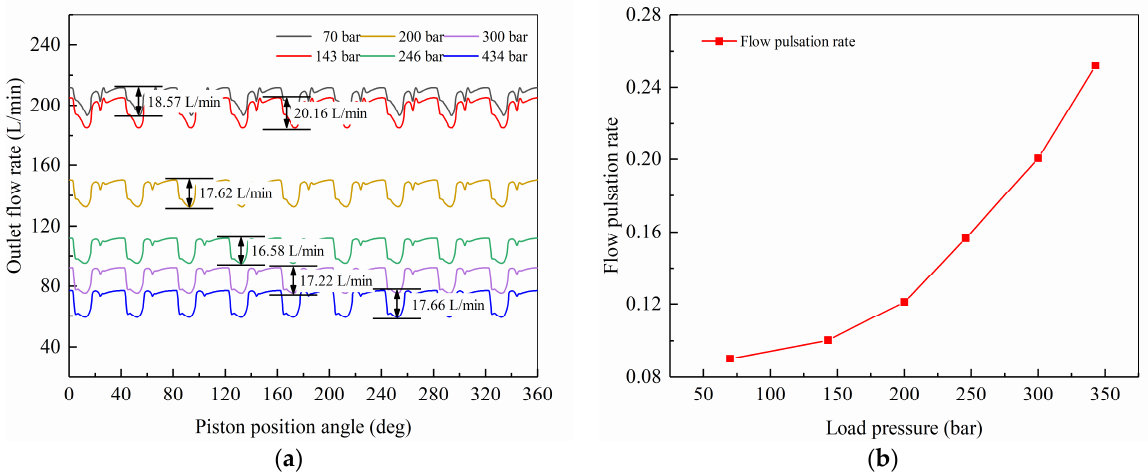
Figure 23. Outlet flow pulsation and pulsation rate under different load pressures: ( a ) outlet flow; ( b ) flow pulsation